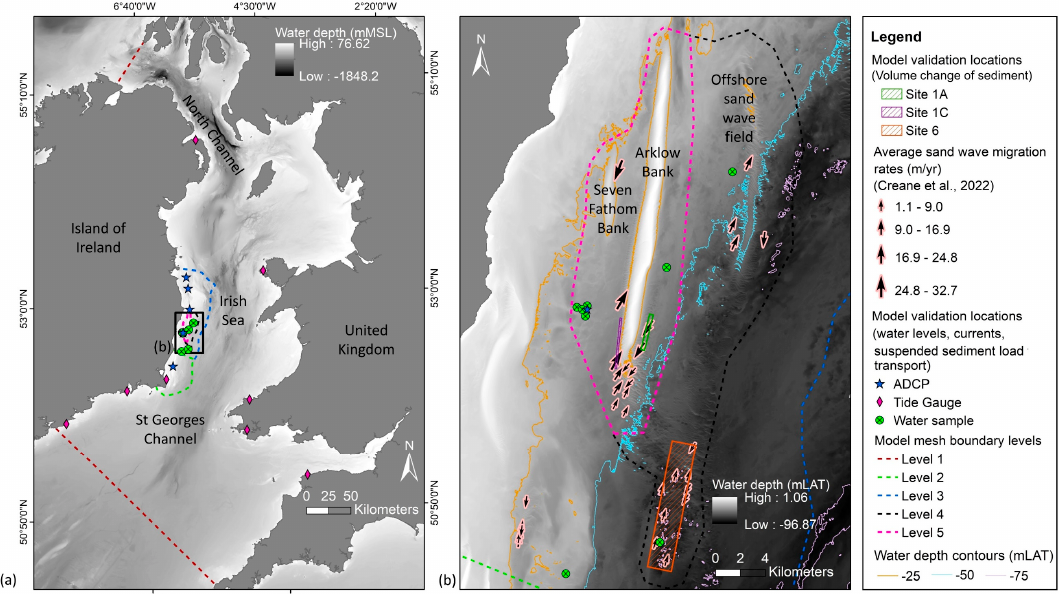
Figure 2. ( a , b ) Numerical model boundaries, mesh resolution levels and validation points [7,32]. Panel ( a ) bathymetry source: EMODnet [27] where MSL is mean sea level; Panel ( b ) bathymetry